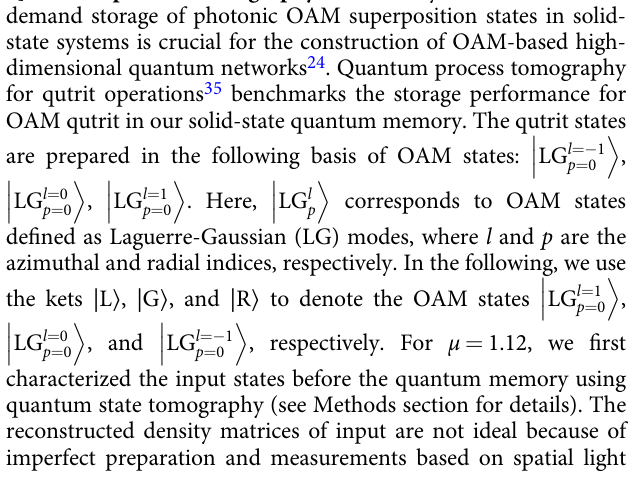
the time histograms of the input photons (blue) and the photons retrieved at 12.68 μ s (green) with a spin-wave storage ef fi ciency η = 5.51%. For an input with a mean photon number μ = 1.12 SW per pulse, we have measured a signal-to-noise ratio (SNR) ~39.7 ± 6.7 with the input photons in the Gaussian mode.